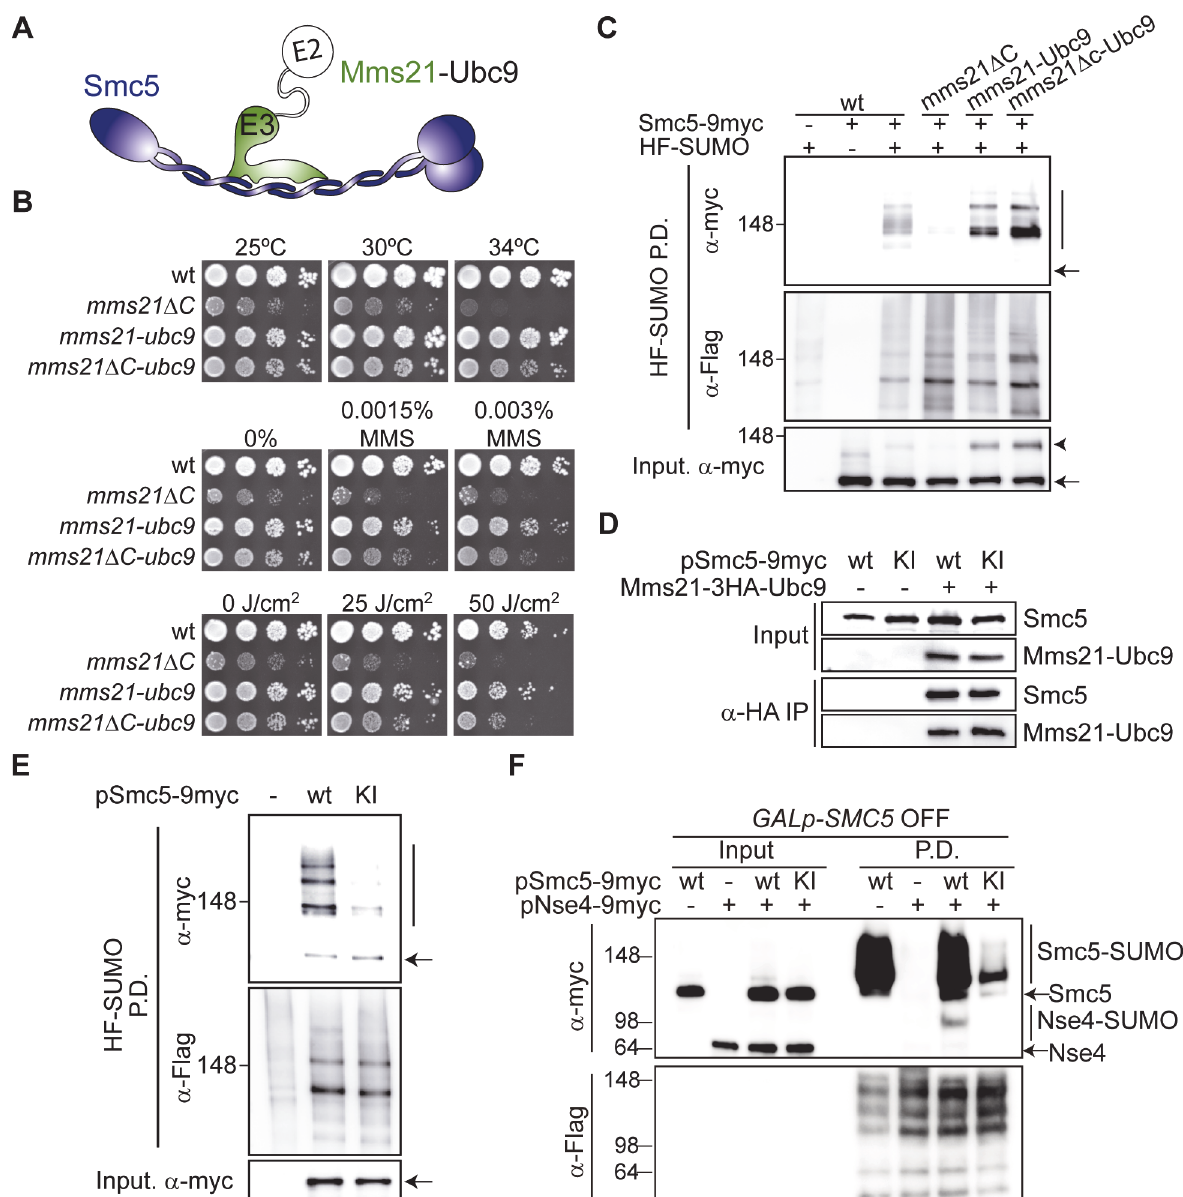
Fig 4. The ATPase in the Smc5/6 complex is part of the ligase mechanism that triggers sumoylation. A. Outline of an Mms21-Ubc9 (E3-E2) fusion, using a 3xHA linker, to force constitutive Ubc9 recruitment in the vicinity of the SUMO ligase. B . Growth test analysis of fusions of the E2 to a full-length Mms21 or to an mms21 Δ c allele lacking its C-terminal domain; plates were incubated at the indicated temperatures, at 25°C in the presence of MMS or at 25°C after irradiation with the indicated doses of ultraviolet (UV). C . Sumoylation analysis of Smc5-9myc under conditions of constitutive Ubc9 recruitment. HF-SUMO was pulled down from wt, mms21 Δ C , mms21-UBC9 , and mms21 Δ c-UBC9 cells that also express a 9myc tagged version of its endogenous SMC5 gene. D . Co-immunoprecipitation analysis of the E3-E2 binding to Smc5. Cells expressing or not an E3-E2 fusion from the MMS21 locus and the indicated SMC5 alleles from a centromeric plasmid, were grown to exponential phase and subjected to anti-HA immunoprecipitation to analyze binding of the fusion to Smc5-9myc. E . Sumoylation analysis of Smc5 under conditions of constitutive Ubc9 recruitment to the Smc5/6 complex. HF-SUMO was pulled down from E3-E2 cells expressing wild-type SMC5-9myc or ATPase-defective smc5(K75I)-9myc from a centromeric vector. F . Sumoylation analysis of Nse4 under conditions of constitutive Ubc9 recruitment to the Smc5/6 complex. HF-SUMO was pulled down from GALp-SMC5 E3-E2 cells, expressing or not the indicated constructs from centromeric vectors, 6 h after shift to glucose to repress expression of the endogenous SMC5 gene. Proteins were separated in a 4% – 15% gradient gel. Note that sumoylation is much stronger for Smc5 than for Nse4. In C and E, arrow points to unmodified proteins; vertical bars are sumoylated forms. In C, arrowheads points to sumoylated Smc5 in the protein extract. In D – F, wt = wild type; KI = smc5(K75I) .